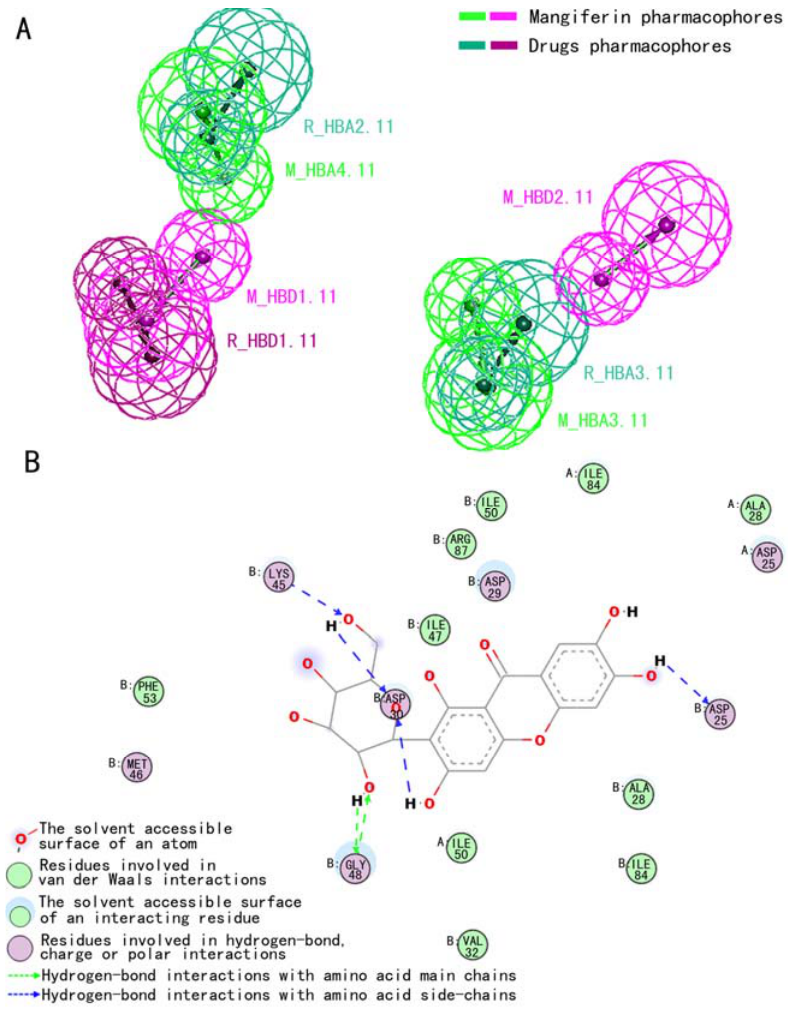
Figure 5. The pharmacophore model alignment between mangiferin and reference